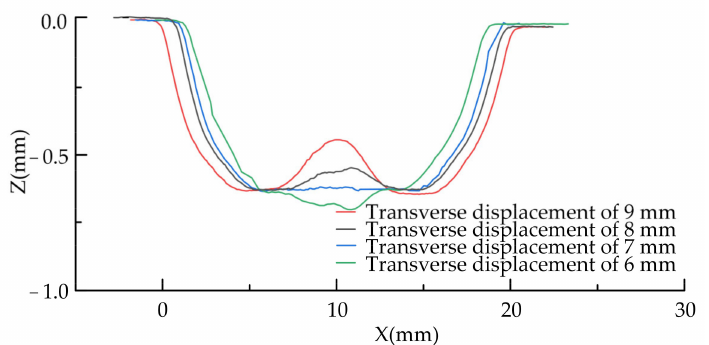
Figure 12. Cross-sectional profiles of machined grooves under different transverse movements.